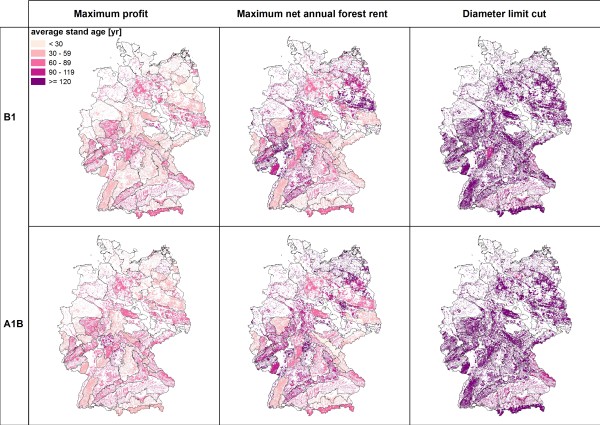
Mean stand age 2100.